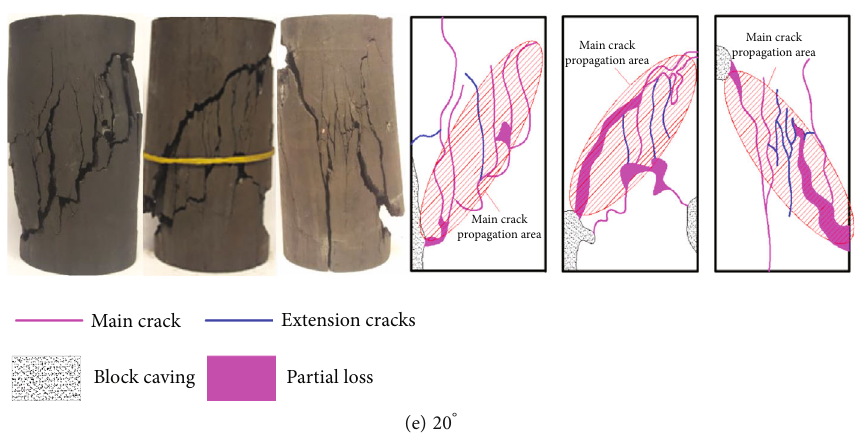
Figure 11: Fracture photographs of coal specimens at various inclination